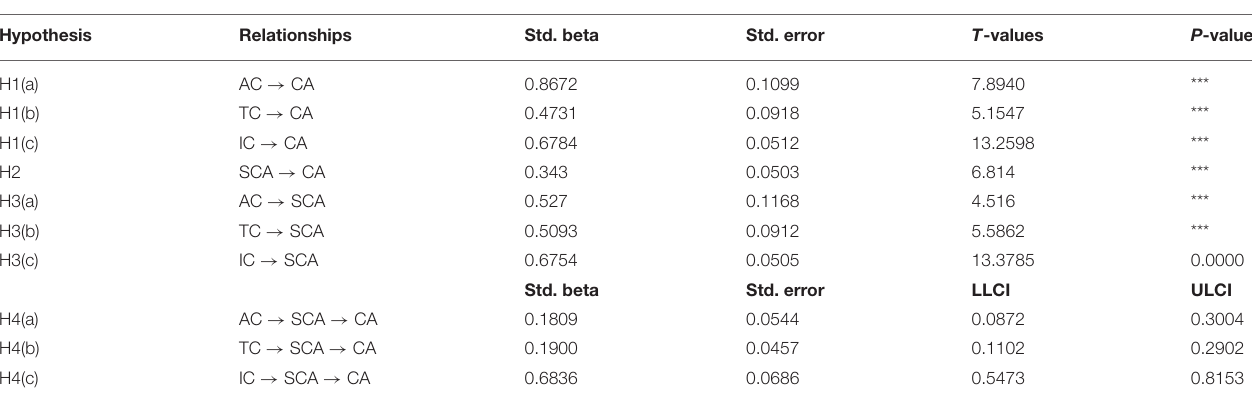
TABLE 3 | Hypotheses